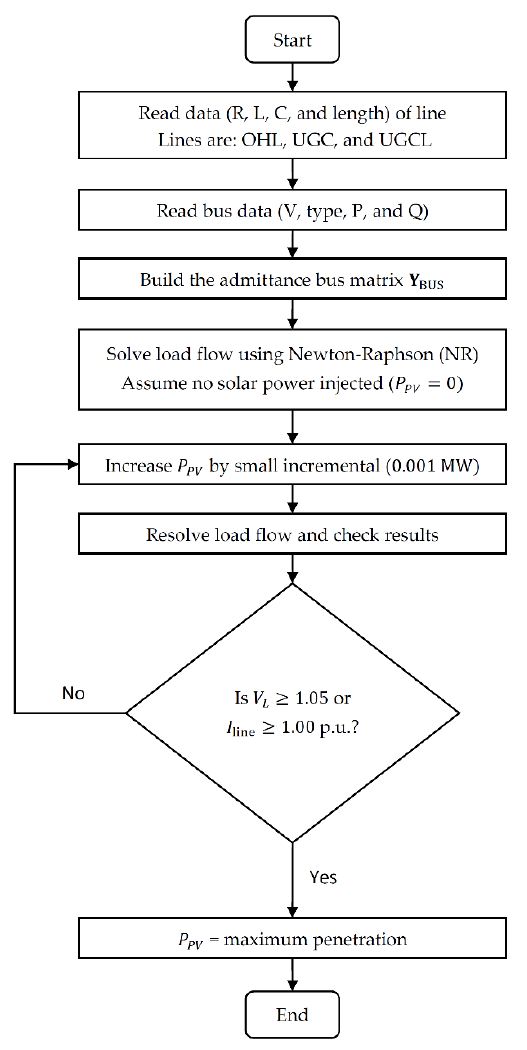
Figure 6. A flowchart describing the methodology used in this paper. ( 𝑃 𝑃𝑉 — photovoltaic plant active power, UGCL — the longer underground cable of 4.46 km, 𝑉 𝐿 — line voltage, and 𝐼 line — line current).